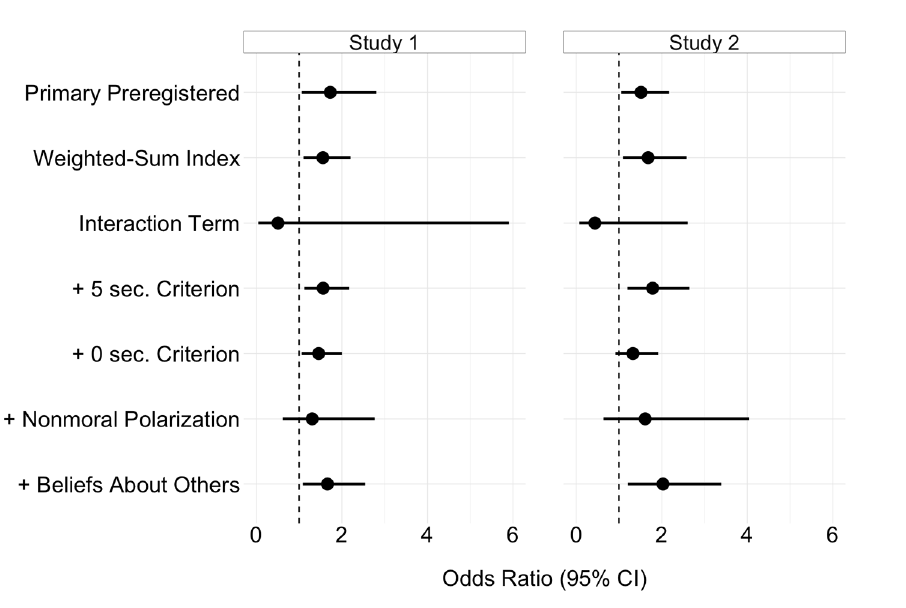
Figure 3. Results of preregistered and exploratory sensitivity analyses in Studies 1 and 2. Note. Panels display Odds Ratios (with 95% confidence intervals) from different models with moral polarization predicting out-party hostility. Models are indexed on the y-axis. The + sign indicates that these models are versions of the Weighted-Sum Index